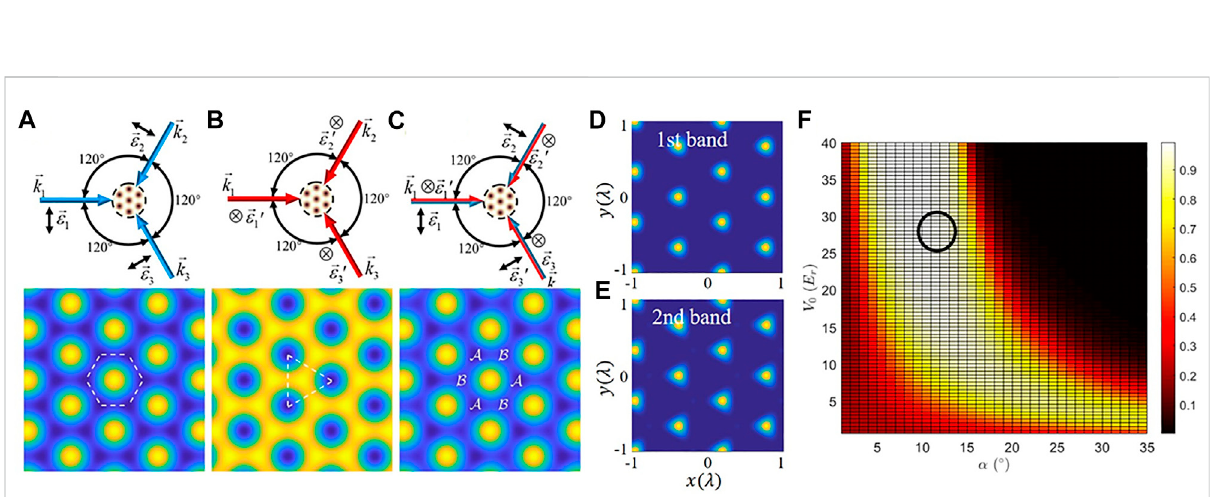
FIGURE 6 The arrangement of the laser beams forms the honeycomb (A) and triangular (B) lattice. The two groups of sublattices form a composite hexagonal lattice (C) ,which consists A and B wells. (D) and (E) represent thewavefunctiondistributionsintherealspaceofthegroundbandandthe second band with zero quasi-momentum, respectively. (F) The wavefunction overlap with different lattice depth and light intensity